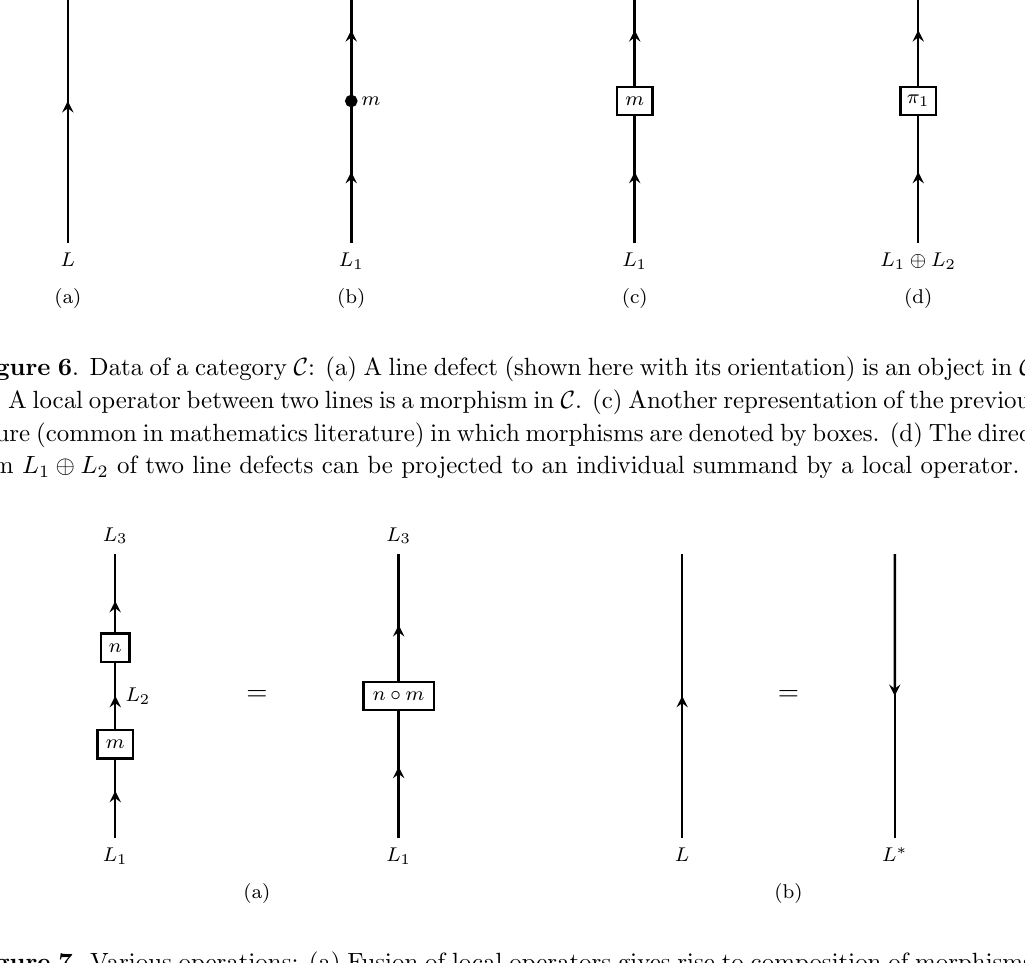
Figure 7 . Various operations: (a) Fusion of local operators gives rise to composition of morphisms. (b) Changing the orientation of a line defect gives rise to the operation of taking dual of an